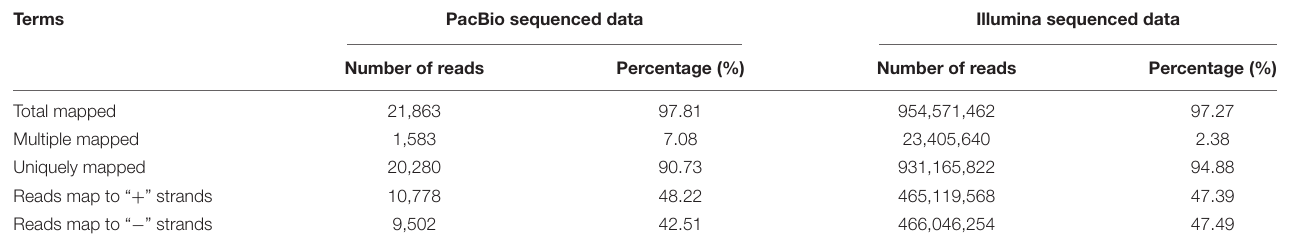
TABLE 2 | Comparisons of PacBio and Illumina sequenced data for read